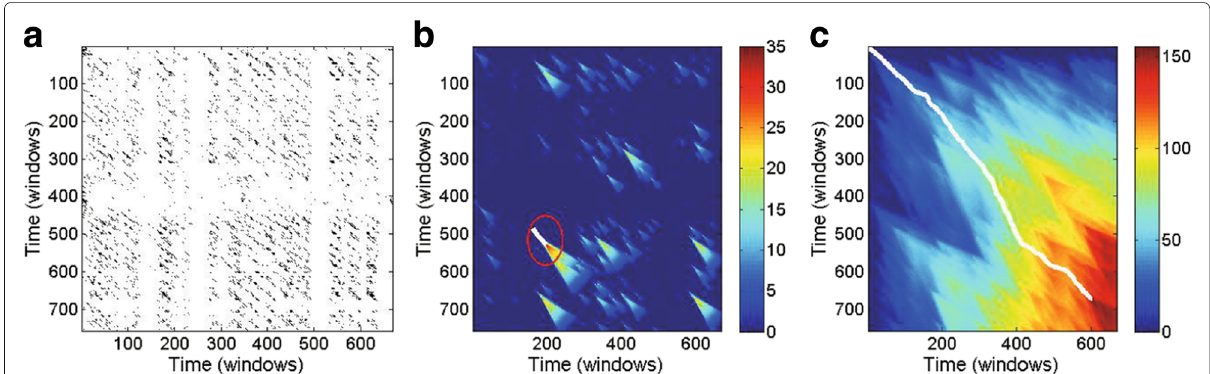
Fig. 3 a The CRP for the song “Addicted to Love” as performed by Tina Turner and Robert Palmer and the corresponding cumulative matrix obtained by the b Qmax and c Dmax